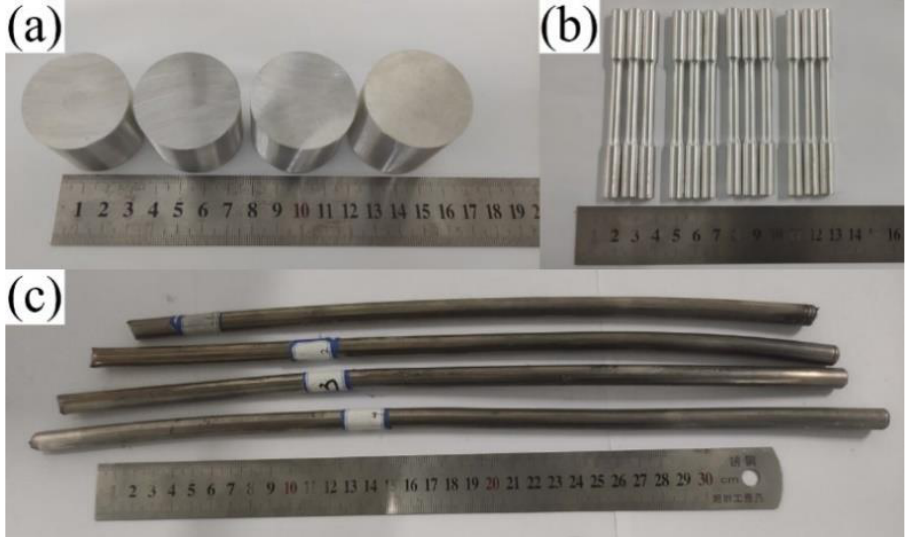
Figure 4. Experimental samples of ( a ) sintered samples, ( b ) tensile test samples obtained by mechani- cal processing of extruded samples, and ( c ) extruded samples.